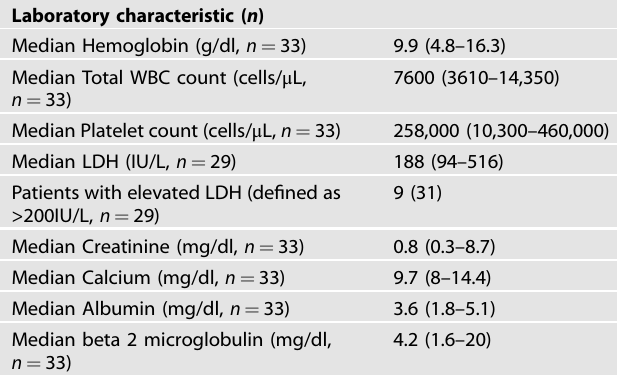
Table 1. Laboratory characteristics of the study patients ( N = 33).